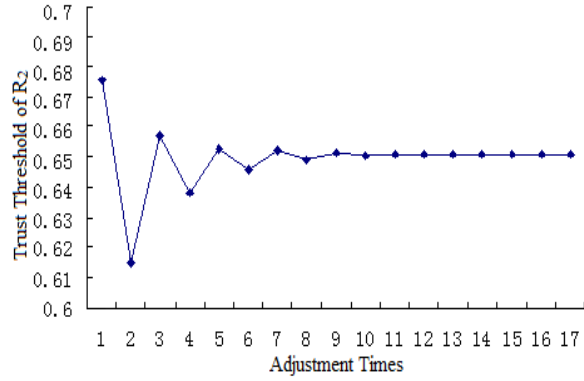
Fig. 5 Trust threshold adjustment for R